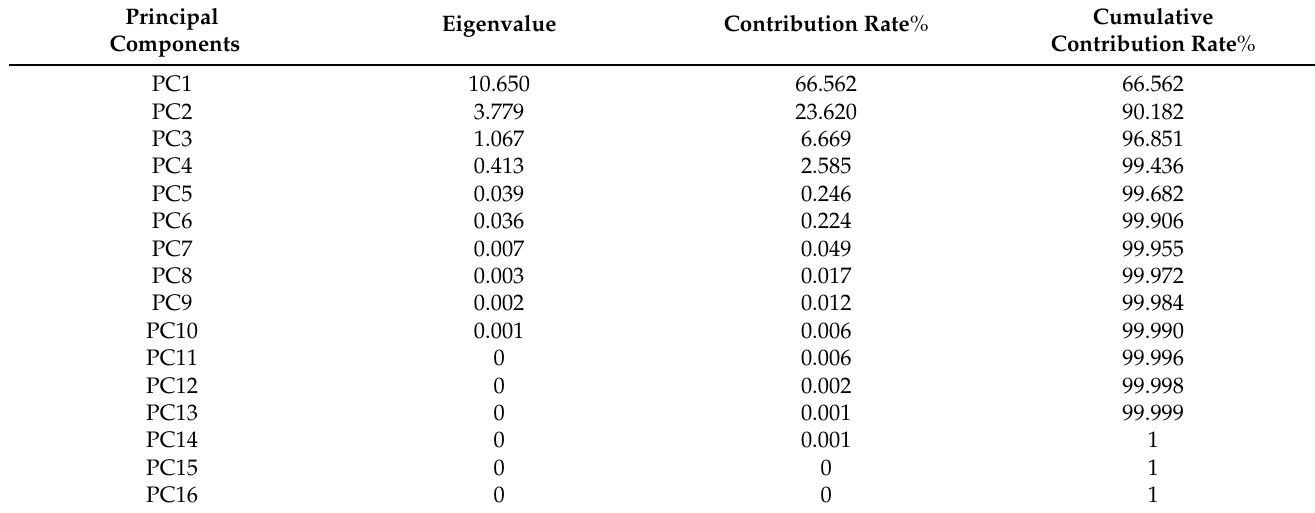
Table 1. Eigenvalues and the contribution rates of 16